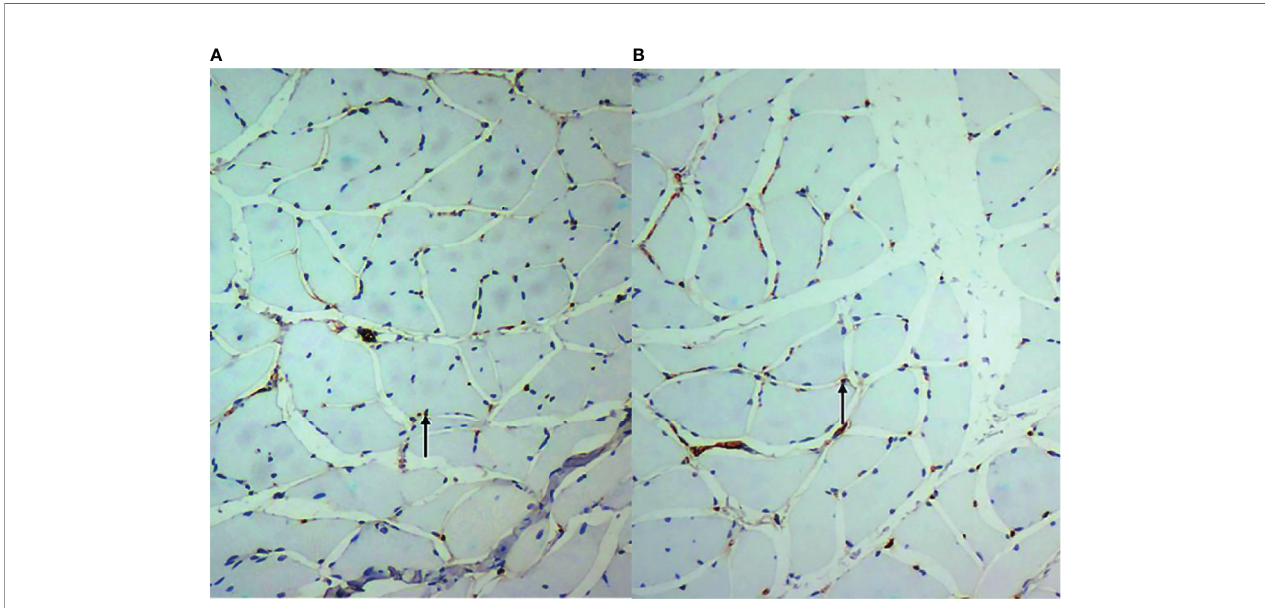
FIGURE 3 | (A, B) show CD31 immunohistochemical staining (×200) in the experimental group and the sham-operated group at week 3, respectively. Microvascular density in the experimental group increased compared with that in the sham-operated group. The brown-yellow particles indicated by the black arrows in are CD31- labelled